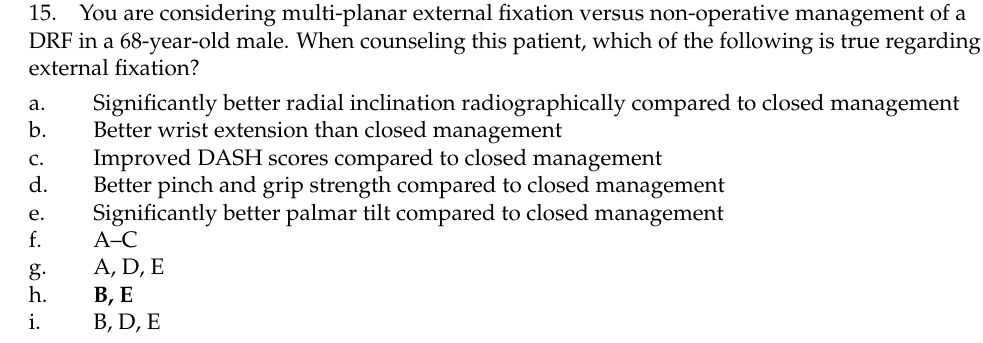
Table A1. Cont. 13. Which of the following factors has been found to significantly impact the DASH score in patients who undergo non-operative management of DRFs? a. Occupation b. Depression c. Hand dominance d. Pain-escaping behavior